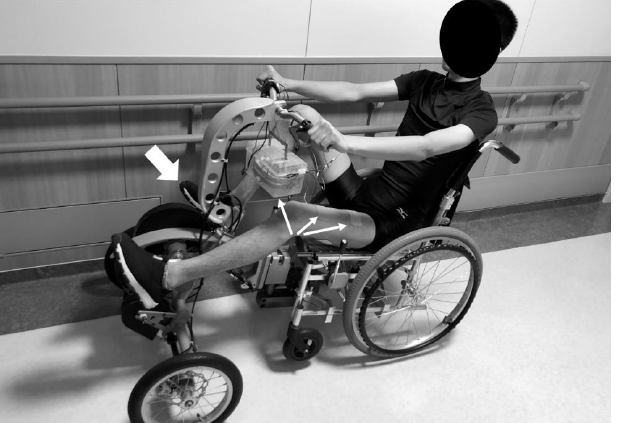
Figure 3. A new functional electrical stimulation (FES) cycling system. The FES cycling system consists of a front-wheel drive unit (thick white arrow) that can be attached to a standard wheelchair and an FES control part (thin white arrows) that enables cycling operation for lower limb paralysis.